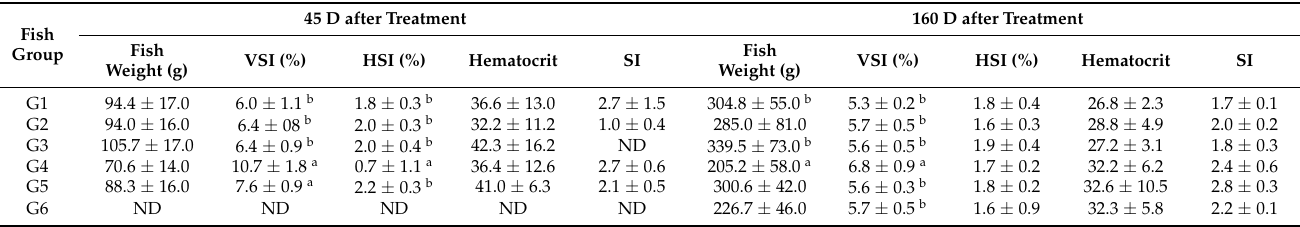
Table 2. Health parameters of fish after